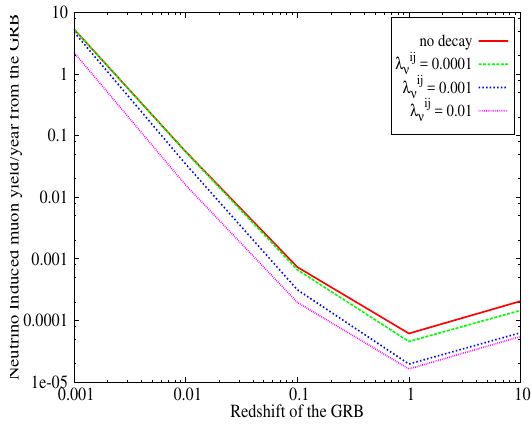
Figure 2 . Variations of the neutrino induced muons per year from the GRB with di(cid:11)erent redshifts ( z ) for three di(cid:11)erent values of j (cid:21) ij j as well as for no decay case at a (cid:12)xed zenith angle ( (cid:18) z = 160 (cid:14) ). (cid:23) See text for details.